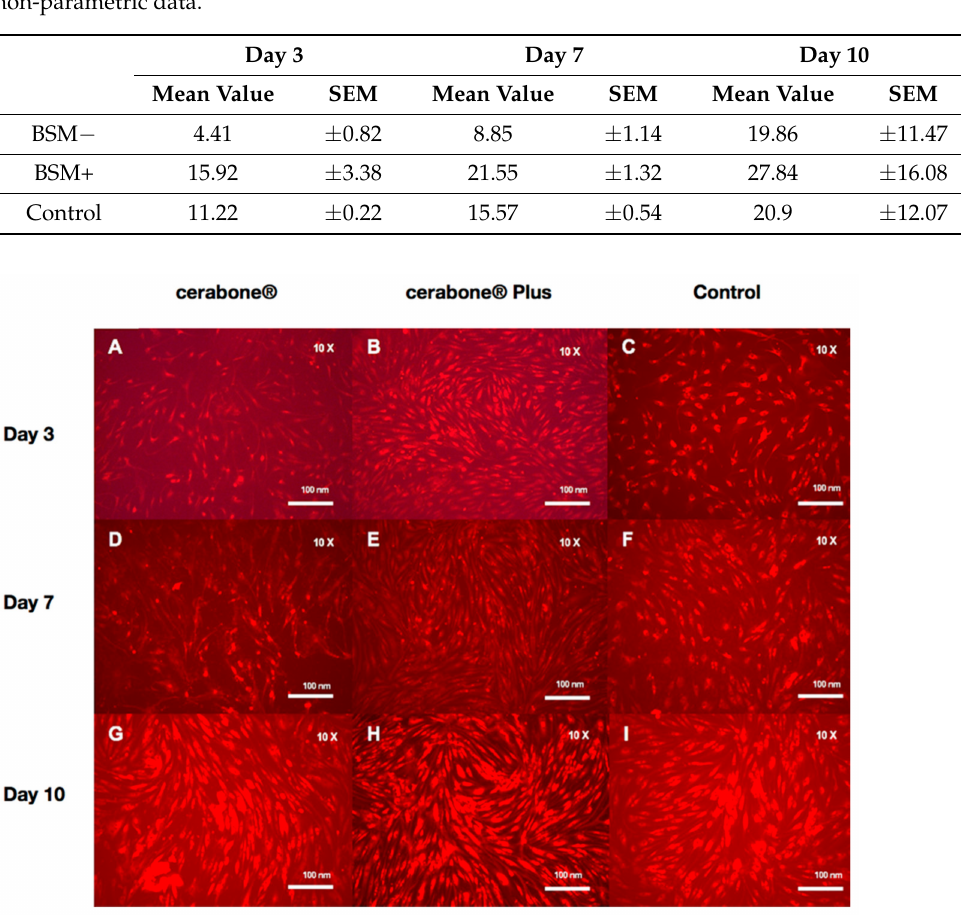
Figure 1. Fluorescence imaging (red cell tracker) in groups with BSM − (cerabone ® ), BSM+ (cerabone ® Plus including HA) and the control (HOB alone) on days 3 ( A – C ), 7 ( D – F ) and 10 ( G – I